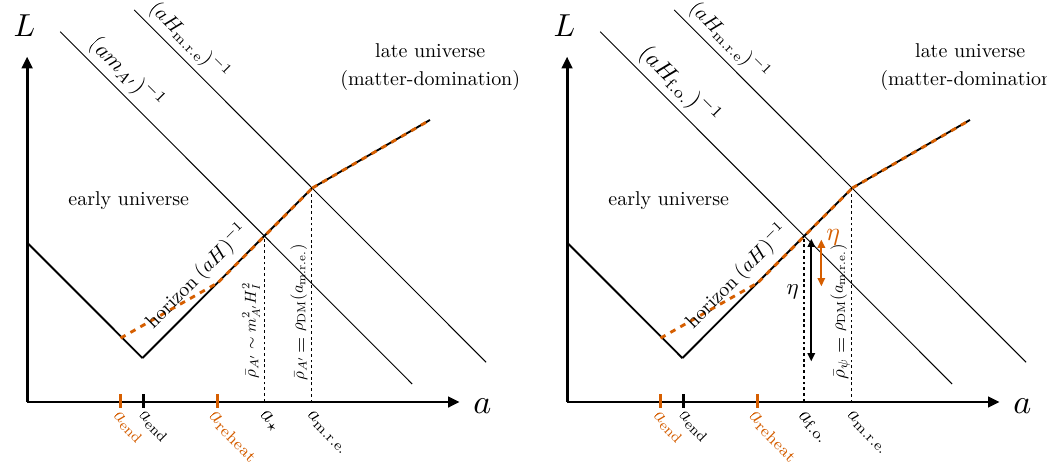
Figure 19. Illustration of the impact of non-instantaneous reheating. We compare the evolution of the important scales in the scenario of instantaneous reheating immediately following the end of inflation, and when inflation is followed by a period of matter-domination (dashed orange